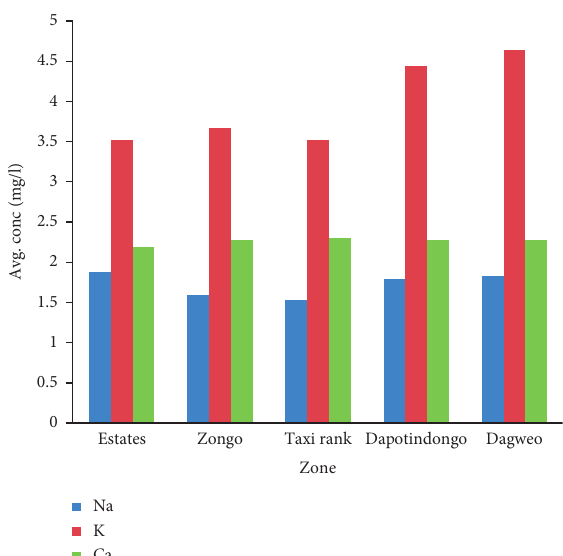
Figure 5: Average concentration of Na, K, and Ca in samples.